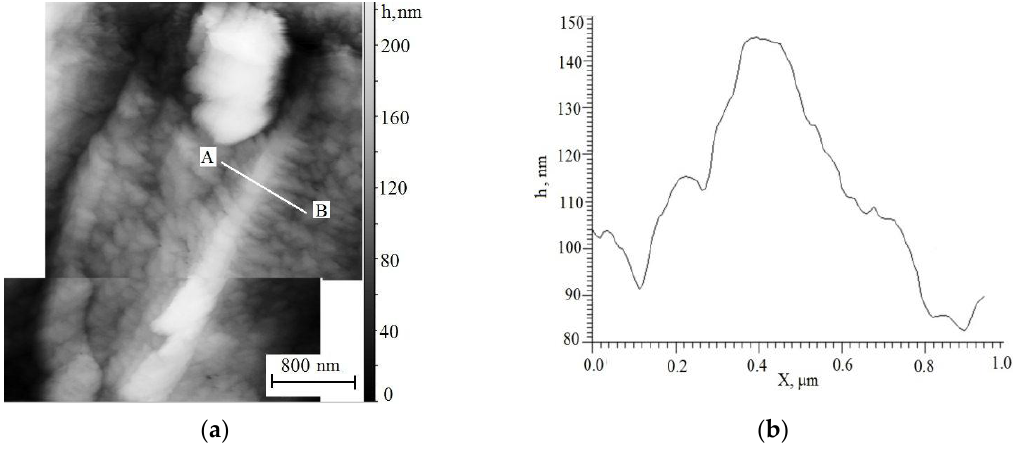
Figure 4. ( a ) Needle subunit in the coating with 0.2 wt% TiCN; ( b ) cross-sectional profile along line AB shown in Figure 4а.